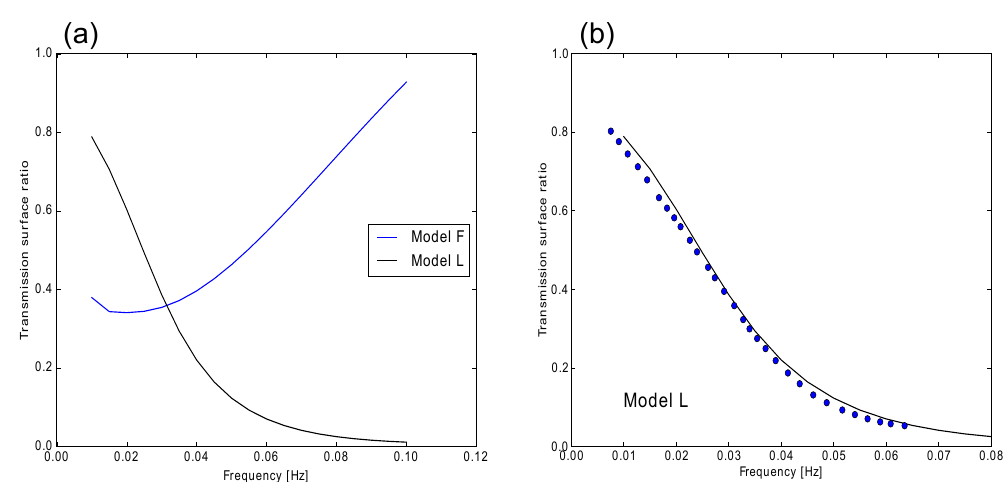
Figure B1. (a) Fundamental mode Love wave surface transmission ratios for models “F” and “L”, which were used by GregAl74 as well as ItsYan85. To be compared with Fig. 5 of ItsYan85. (b) SWRT result for model L (solid line, same as in a ) compared with values obtained by manually digitizing Fig. 5 of ItsYan85 (circles).